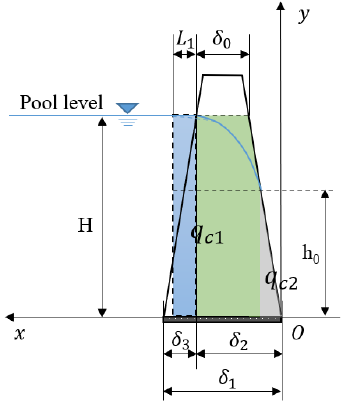
Figure 5. Calculation of seepage flux through the core.